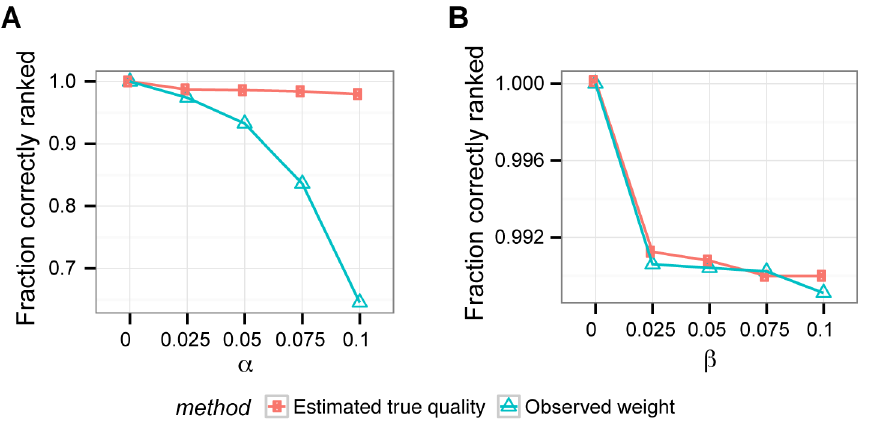
Figure 4. Improved ranking of erroneous patterns. In contrast to the observed weight, which was applied in previous studies, and ignores errors and scores observed coverage and impurity, our approach to estimate true quality, using known error rates, estimates the true parameters and ranks the patterns correctly. The data was simulated from the mutual exclusivity model with parameter values fixed to c [ f 0 : 2,0 : 4 : 0 : 6,0 : 8 g , d [ f 0 : 02,0 : 05,0 : 08 g , with error rates A a [ f 0,0 : 025,0 : 05,0 : 075,0 : 1 g (x-axis), b ~ 0 , as well as B b [ f 0,0 : 025,0 : 05,0 : 075,0 : 1 g (x-axis), a ~ 0 . 20 datasets with 5 genes and 1000 patients were simulated per each parameter setting.